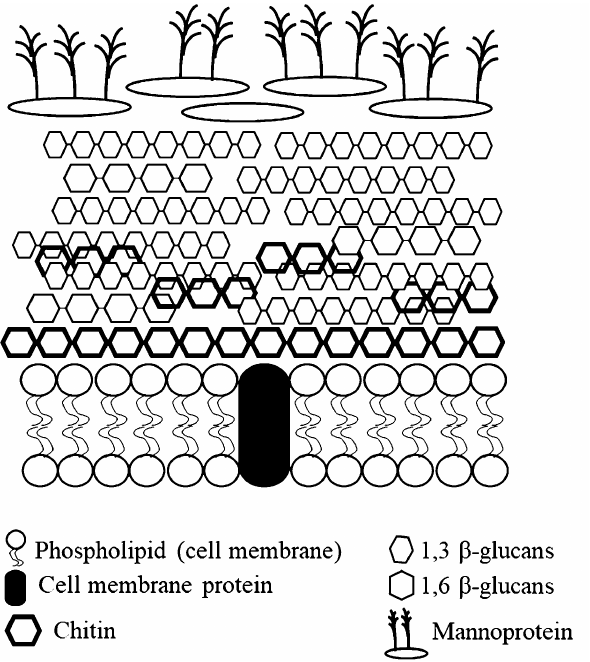
Figure 2. The structure of yeast cell wall. Concepts were based on Lipke and Ovalle (1998) [45]; Kogan et al. (2008) [46]; Morphology (2012) [32]).